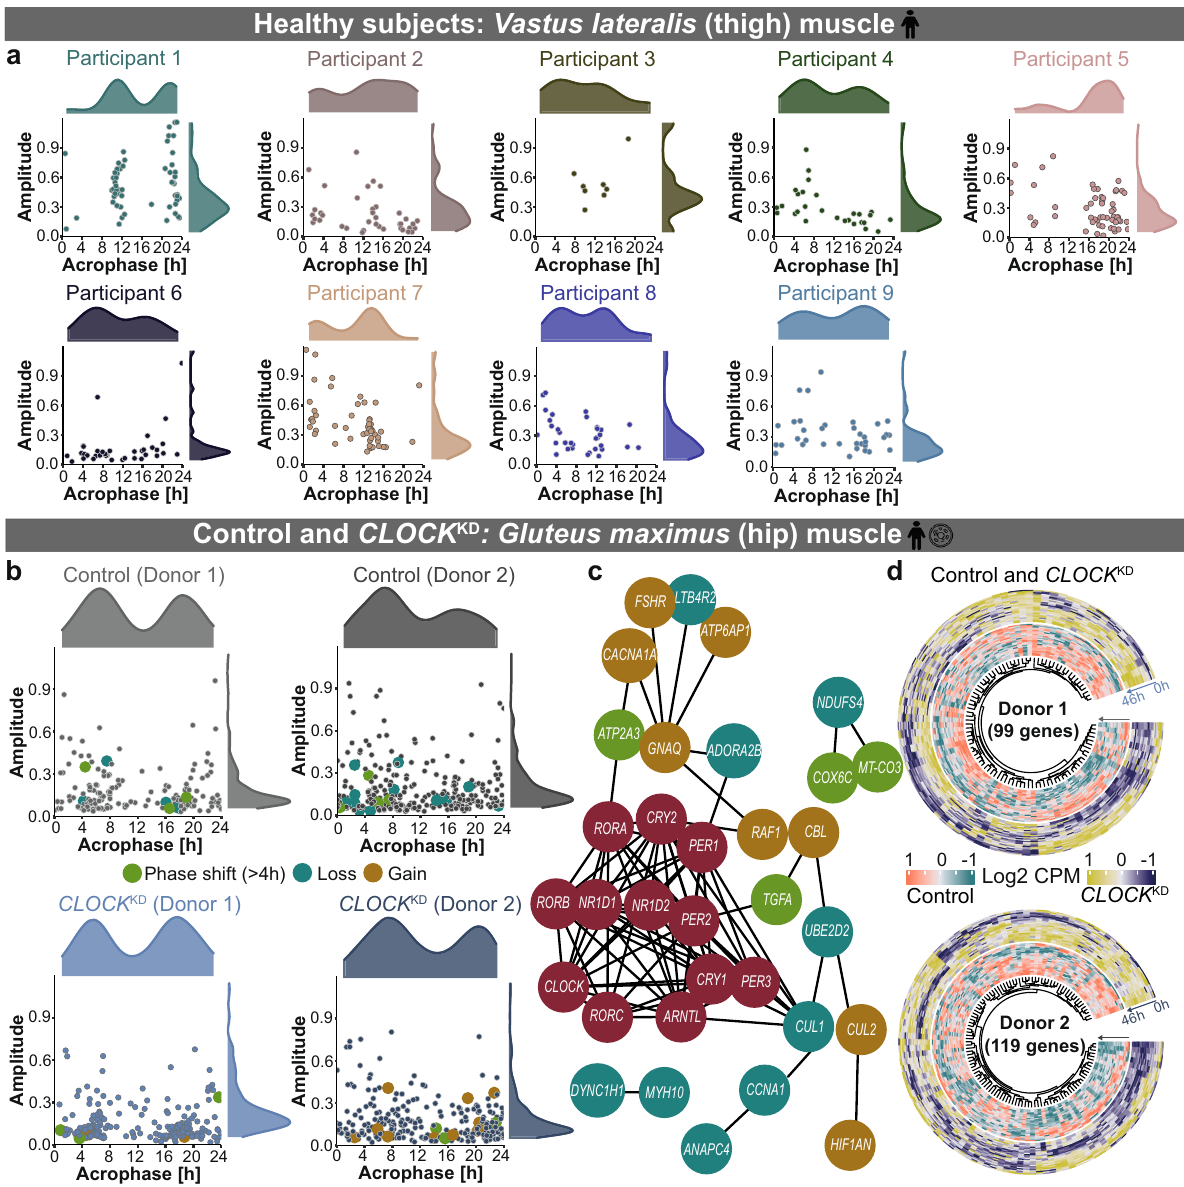
Fig. 2 Genes of interest exhibit circadian properties in human healthy muscle tissue and cells which are altered upon CLOCK KD . Scatter plot depicts the distribution of circadian (~24 h) genes of interest in ( a ) muscle biopsies collected from nine healthy participants and ( b ) myotubes cultured cells from two healthy control donors (upper panel) and siRNA transfected CLOCK KD cells (lower panel). c STRING network depicts the interaction between differential rhythmic genes due to CLOCK KD and the core-clock genes (red circles). d Circular heatmap visualizes the differentially expressed genes of interest due to CLOCK KD vs. WT in donor 1 (upper panel) and donor 2 (lower